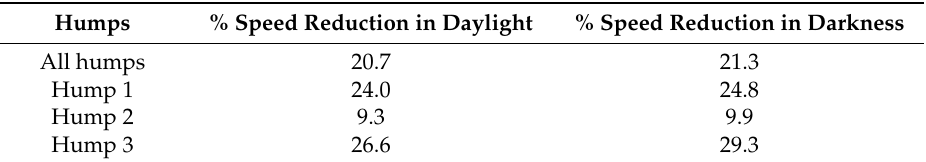
Table 4. Percentage speed-reducing effect of humps compared with the posted speed limit (30 km/h) in daylight and